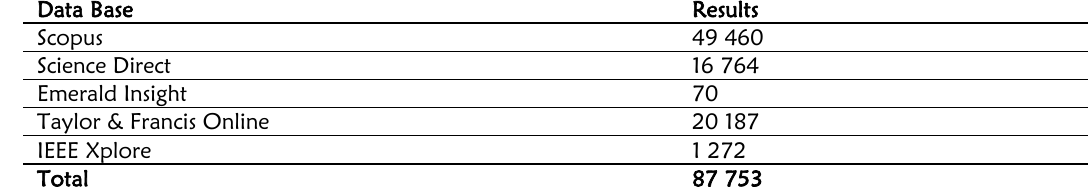
Table 3: Numbers of articles found based on search string